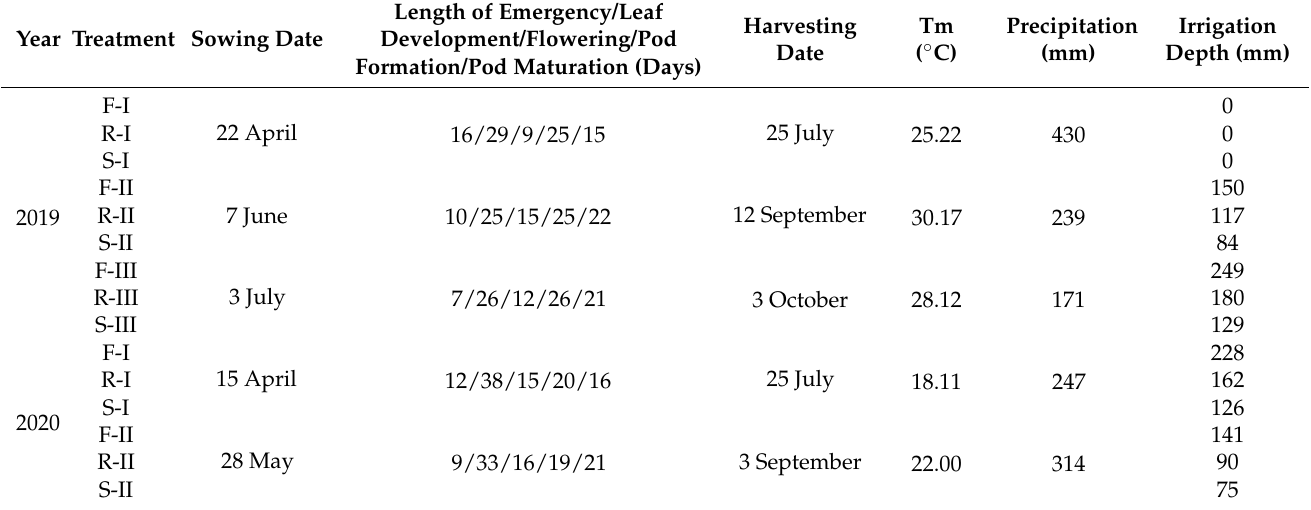
Table 1. Sowing and harvesting dates with lengths of important growing phases of common bean and climatic characteristics during